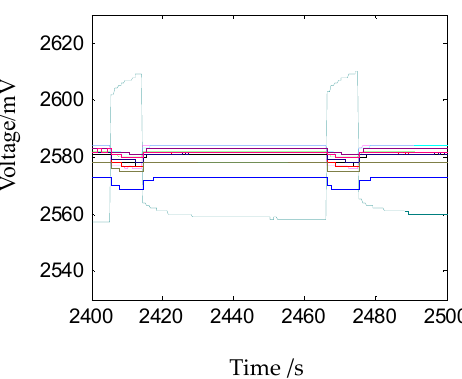
Figure 18. Equilibrium at final stage.